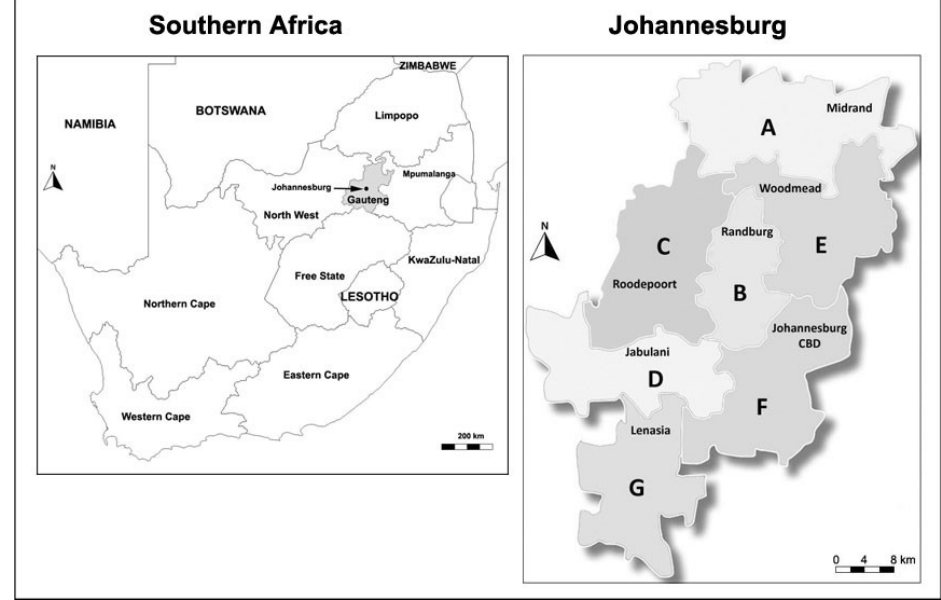
Figure 1. Geographical location of the study area in South Africa and the different regions of the CoJ.